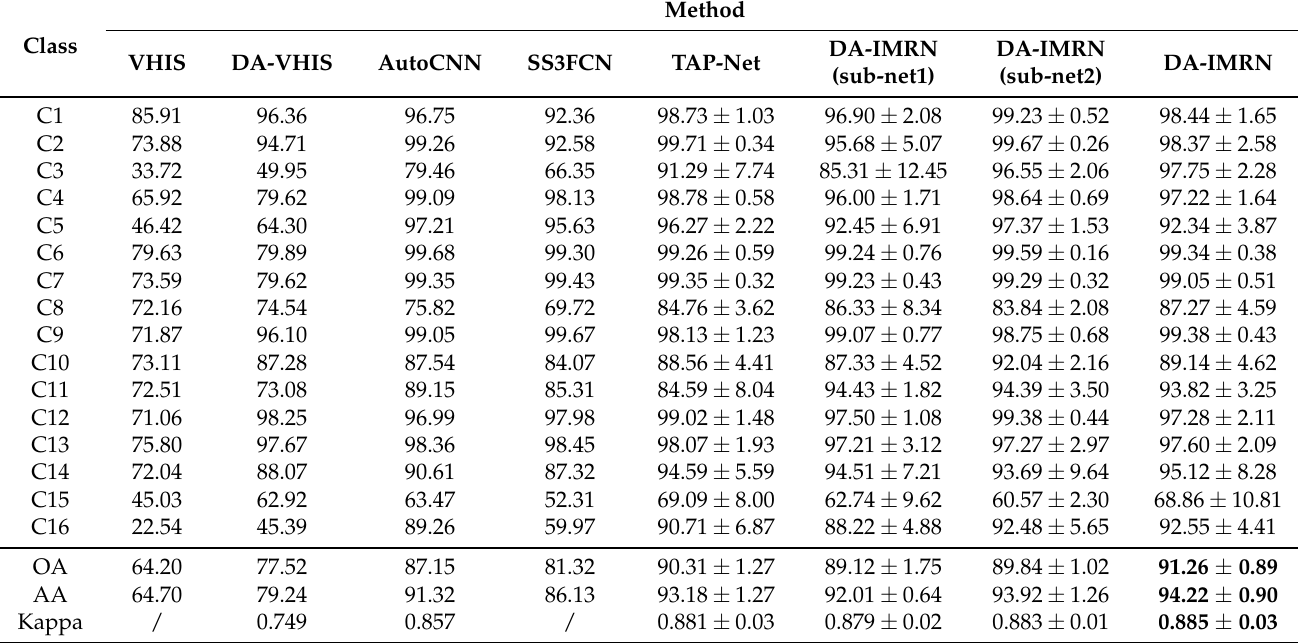
Table 3. Salinas Valley dataset: Classification results in terms of per-class accuracy, OA, AA (in %), and the Kappa scores. In the last four columns, the results are displayed in the form of mean ± standard